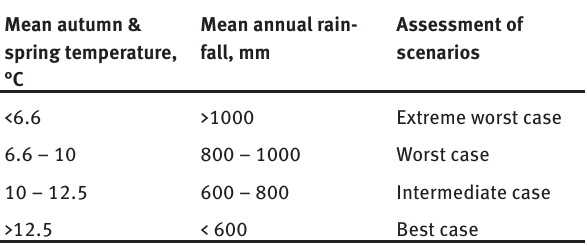
Table 3: Mean annual and seasonal air temperature and precipitation (meteostation of Moscow State University) Period